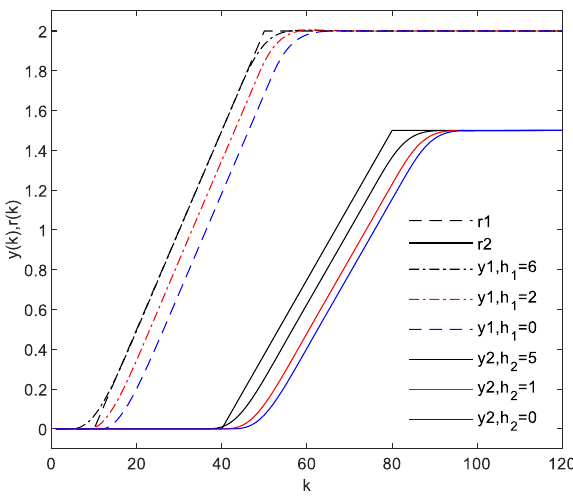
Figure 1. The output response and the reference signals.